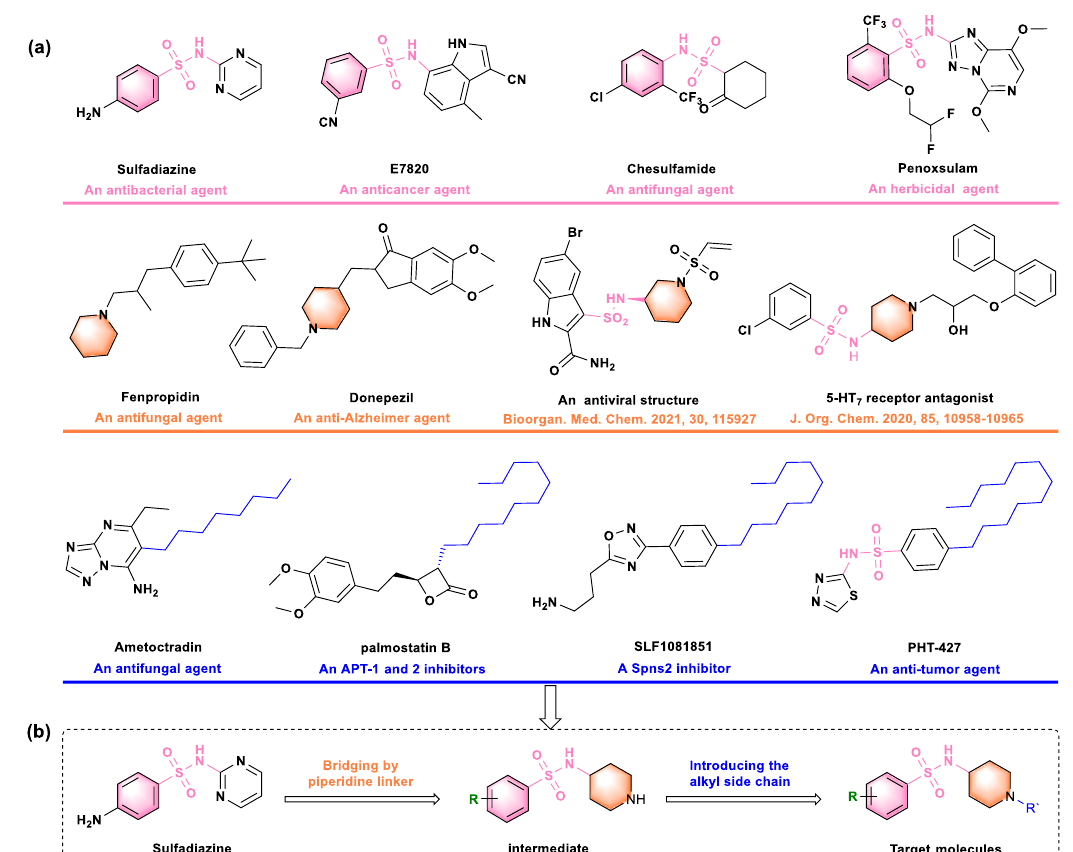
Figure 1. ( a ) Some commercial and reported bioactive compounds containing the sulfonamide, piperidine, or alkyl side chain unit. ( b ) The design strategy for title molecules.